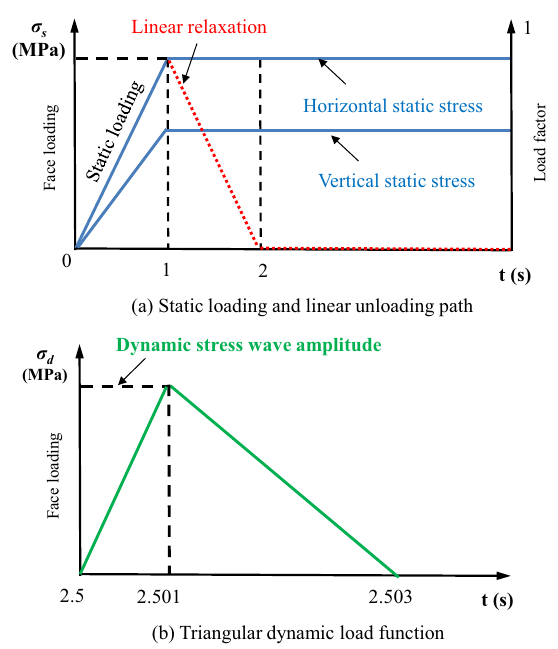
Fig. 3 Stress path applied in the model. a Loading and unloading path; b Triangular load function. Note: σ s indicates the initial static stress, and σ